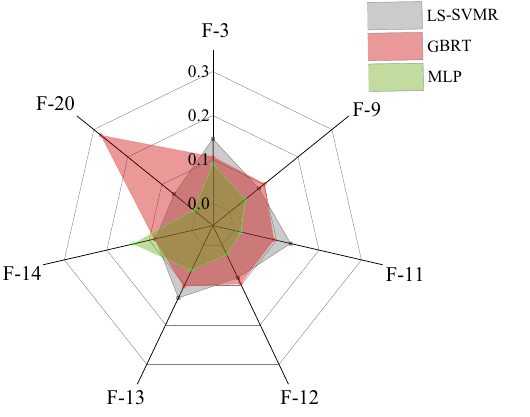
Fig. 6 Data distribution of added MAPE and